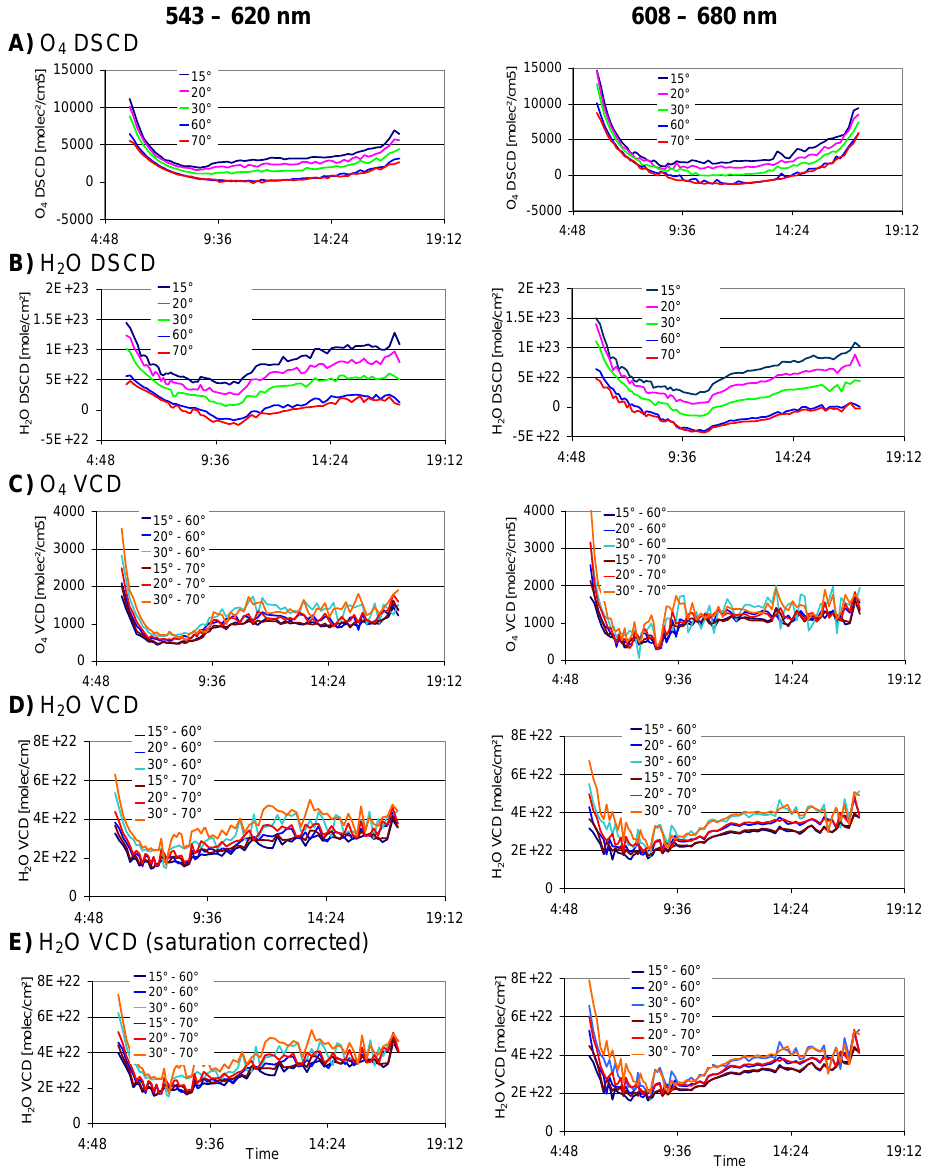
Fig. 3. DSCDs ( A and B ) and VCDs ( C , D and E ) of H 2 O and O 4 retrieved on a clear day (23 March 2011) in the yellow spectral range (left) and red spectral range (right). The VCDs are calculated from different combinations of high and low elevation angles using the geometric approximation. For H 2 O, a saturation correction (see text) was applied.